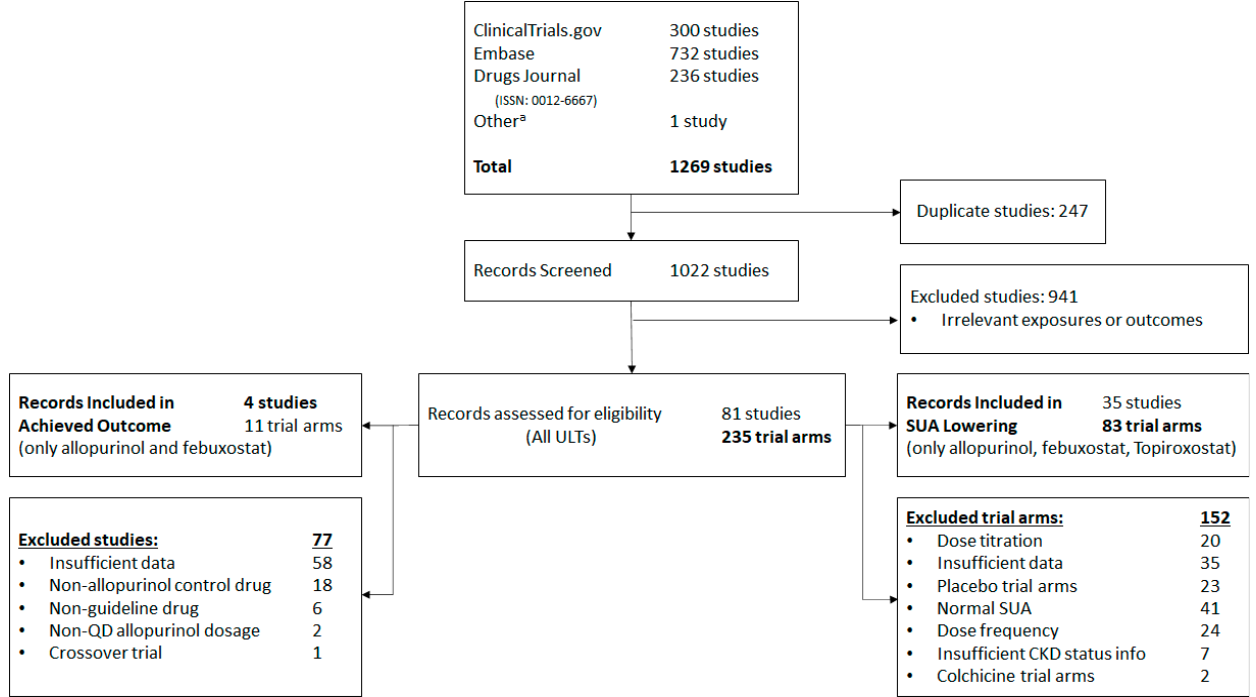
Figure 1. Flow diagram. Summary of literature search and selection process. Note . CKD: chronic kidney disease; QD: quarter in die (four times a day); SUA: serum uric acid; and ULT: uric lowering therapy. a One study was listed as a reference for an article sourced through Embase